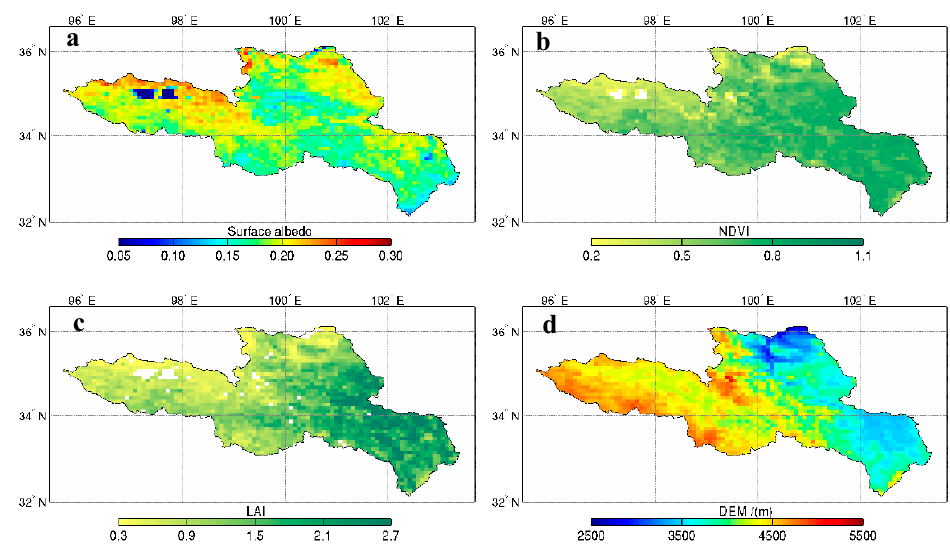
Figure 2. Surface parameters of the SRYR ( a ) Surface albedo ( b ) NDVI ( c ) LAI ( d ) DEM.